Question: How would you classify this visualization?
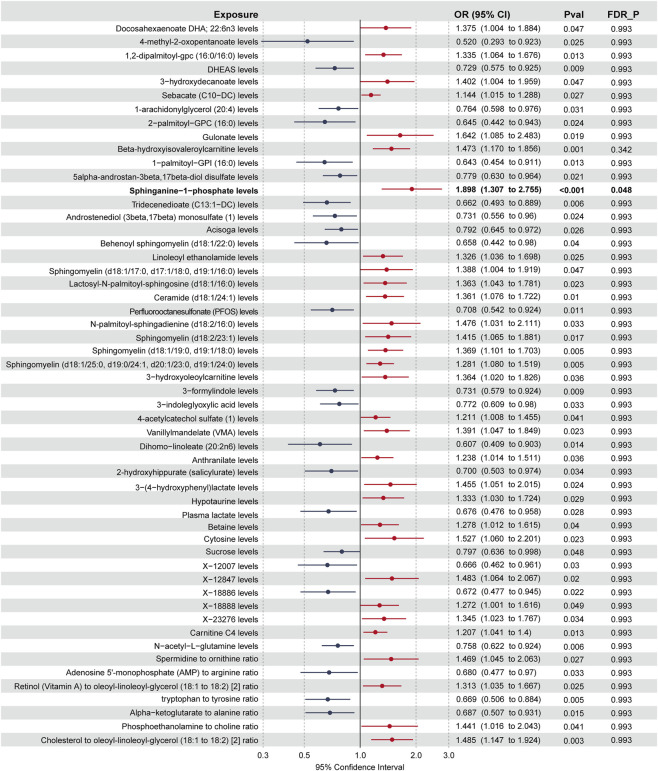
Answer: forest